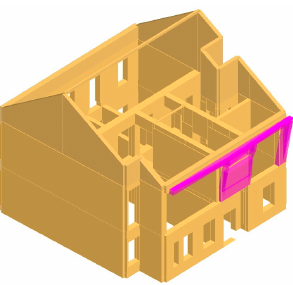
Figure 15. Damage at maximum displacement capacity for pushover in the Y direction; ( a ) shear failure of the wall: ( b ) bending failure of the wall; ( c ) bending damage above the windows in the lintels